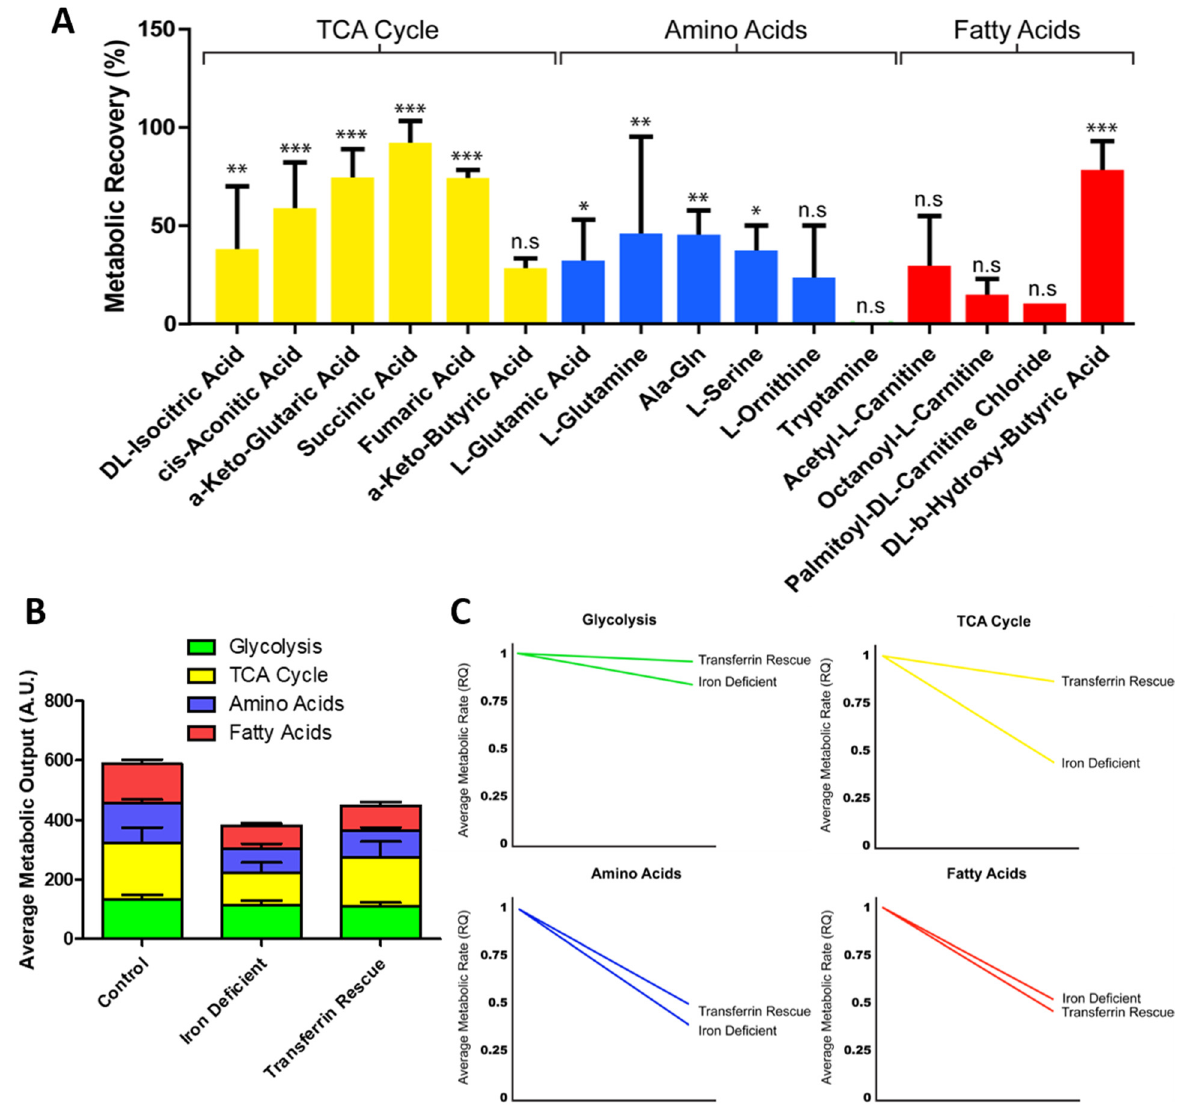
Figure 5. Change in metabolism during transferrin rescue of iron-deficient hiPSC-CMs. Substrate maximum metabolic capacity for transferrin-rescued hiPSC-CMs normalised to iron-deficient hiPSC-CMs. n = 3 ( A ). In ( B ), the maximum metabolic peak is averaged for each of the glycolysis, TCA cycle, amino acid, and fatty acid substrate groups and plotted as a percentage of total metabolic output. In ( C) , the relative fold change in the rate of grouped substrates is plotted for iron-deficient and transferrin-rescued hiPSC-CMs compared to control. Significance was determined by two-way ANOVA, * p < 0.05, ** p < 0.01, *** p < 0.001.